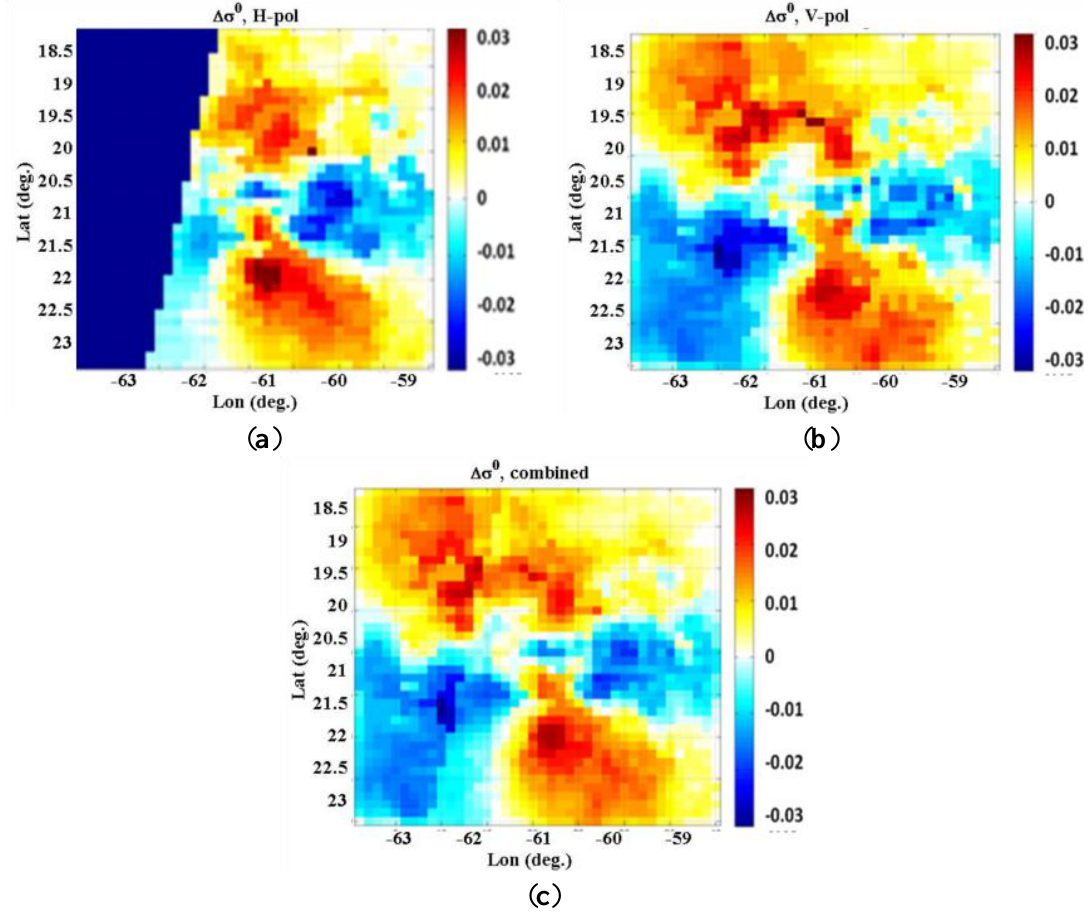
Figure 3. Observed ocean backscatter difference ( Δ𝜎 𝑀𝑒𝑎𝑠0 , (forward-aft looks)) from Hurricane Fabian (Rev. # 21898) for: ( a ) horizontal polarization, ( b ) vertical polarization, and ( c ) average of horizontal and vertical